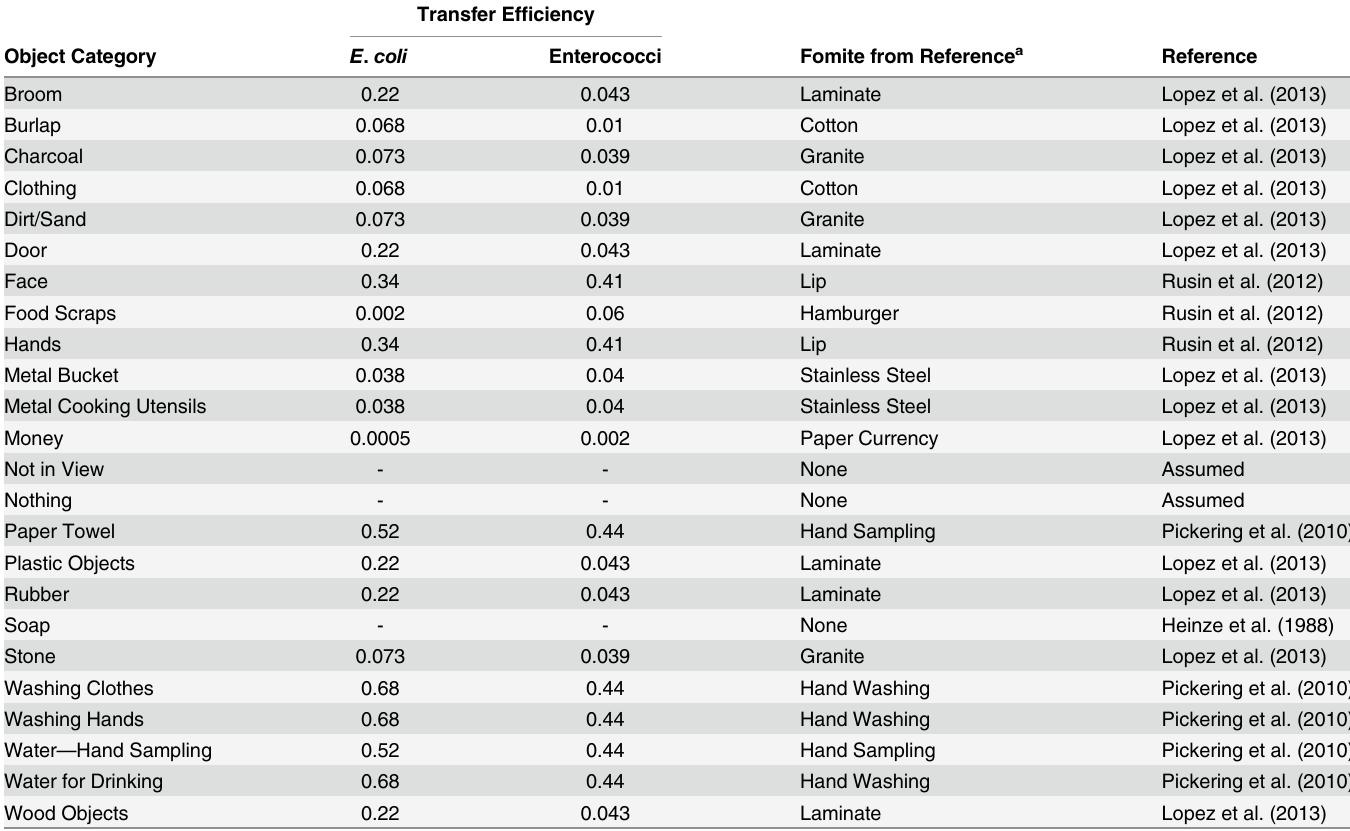
Table 2. Fractional Transfer Efficiency Values Used in Exposure